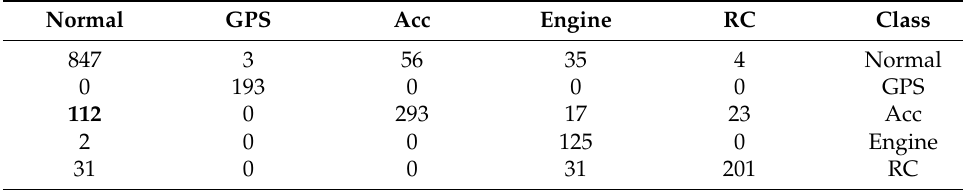
Table 13. Confusion matrix of random forest